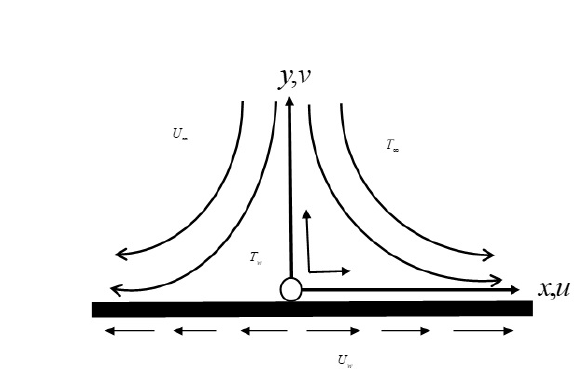
Fig. 1: Physical sketch of the stagnation point flow